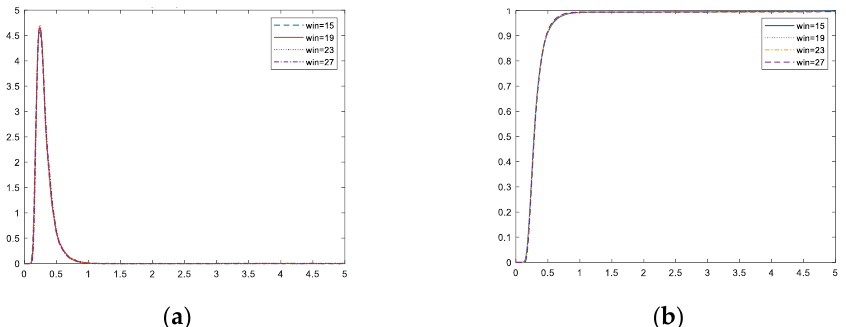
Figure 7. ( a ) PDF estimation of 𝑃 vi and ( b ) CDF estimation of 𝑃 vi . The win in the figure represents the patch size.